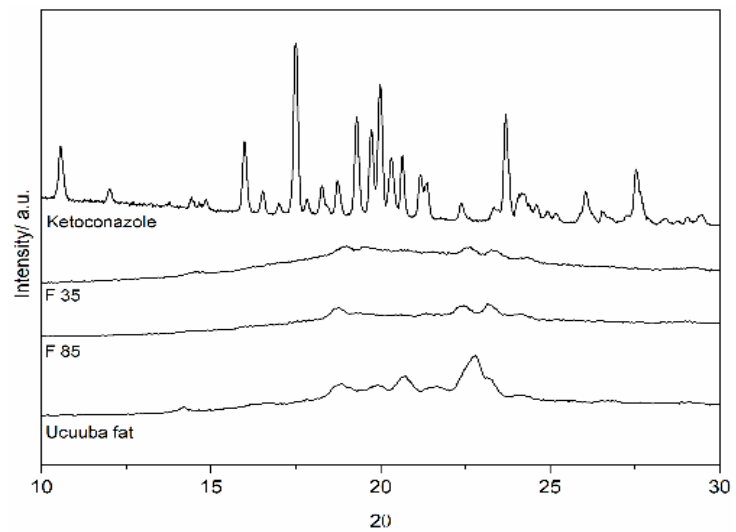
Figure 8. The X-ray diffraction spectra of Ucuùba fat and optimized Ucuùba fat NLC formulations F 30 and F 85.